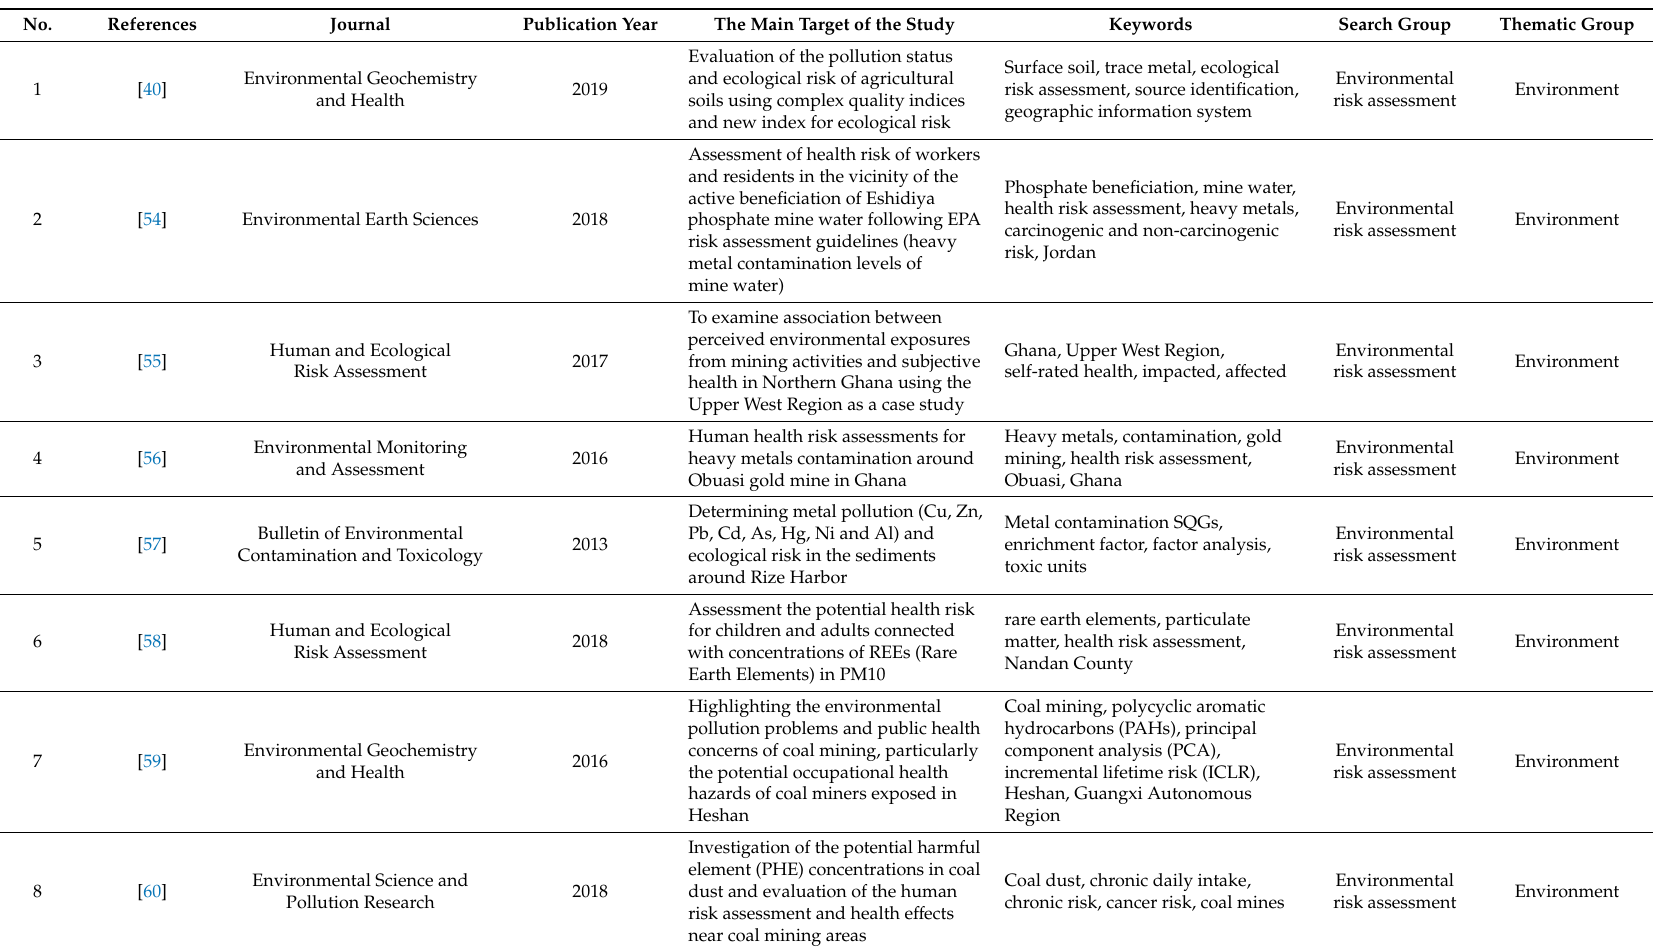
Table A2. Summary of the reviewed